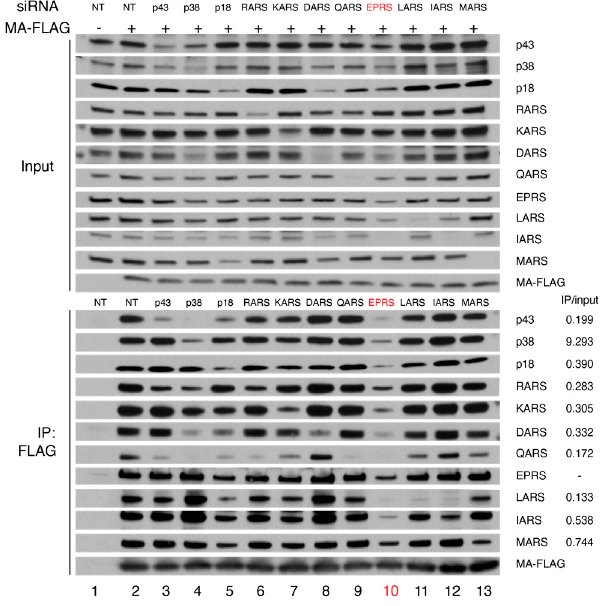
Figure 2. FLAG-IP in the absence or presence of siRNA knockdown of MSC proteins. Immunopre- cipitation was performed using FLAG antibody in HEK293 cells without (lane 1) or with (lane 2) expression of MA-FLAG in the presence of a non-targeting (NT) siRNA. Lanes 3–13: siRNAs target- ing each MSC component were expressed, and FLAG-IP was carried out for each knockdown. Top shows input signals indicating successful knockdowns, and bottom shows the results of the FLAG-IP. IP versus input ratios (siEPRS relative to NT) are labeled on the bottom right.